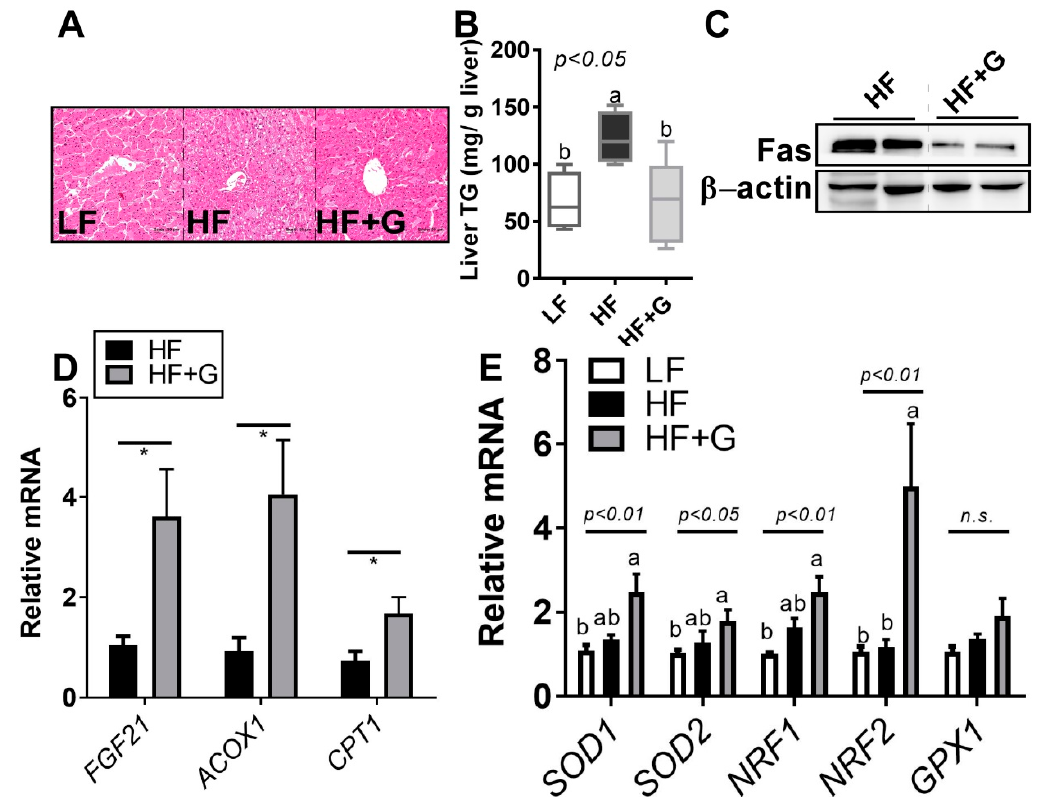
Figure 3. Ginger supplementation reduced HF-diet-induced hepatic lipid accumulation. Male 6-week-old C57BL/6 mice were fed an LF (white), HF (black), or HF + G (gray) diet for 7 weeks ( n = 4–5 per group). ( A ) Hematoxylin and eosin (H&E) staining of liver tissue (20 × magnification); ( B ) hepatic TG content (mg/g liver); ( C ) hepatic fatty-acid synthase (Fas) protein expression; ( D ) hepatic messenger RNA (mRNA) expression of fibroblast growth factor 21 (FGF21), acyl-CoA oxidase 1 (ACOX1), and carnitine palmitoyltransferase 1 (CPT1) determined using real-time PCR; and ( E ) superoxide dismutase 1 (SOD1), SOD2, nuclear factor erythroid 2-related factor 1 (NRF1), NRF2, and glutathione peroxidase 1 (GPX1) gene expressions quantified by real-time PCR. Data are expressed as the mean ± SEM ( n = 4–5). n.s. represents no significance. Bars with different letters are significantly different according to one-way ANOVA with Bonferroni’s comparison test; * p < 0.05 (HF vs. HF + G) with Student’s t -test.